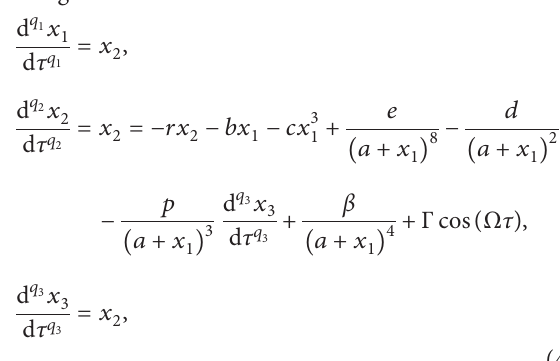
� 1.0 and (b) q � 3 3